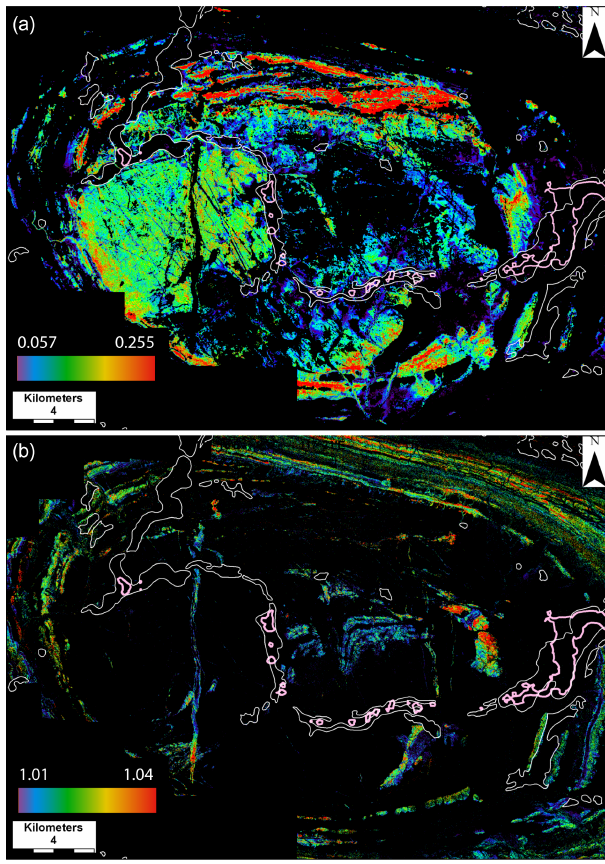
Figure 3. (a) White mica ( + Al-smectite) and (b) chlorite ( + epidote, + biotite) abundance maps of the Rocklea Dome area, calculated from airborne hyperspectral data using algorithms de- scribed in Table 1. Warm colours represent high abundance, and cool colours low abundance of the respective minerals. Black pixels have been masked out as relative intensity of the absorption feature mapped in the respective mineral map is below a given threshold (Table 1) and/or because of non-mineralogical effects (e.g. vegeta- tion, clouds). Panel (a) shows monzogranites in the western part of the dome in green colours and the Fortescue Group in the north- ern fringe of the dome in red colours. Panel (b) highlights Archean metamorphosed basalts in the eastern part of the dome structure and an N–S-trending amphibolite dyke in the western part of the dome. White lines indicate the surface extension of the Tertiary palaeochannel as mapped by Thorne and Tyler (1996). Pink lines indicate the horizontal extension of the Tertiary palaeochannel as mapped by the hyperspectral